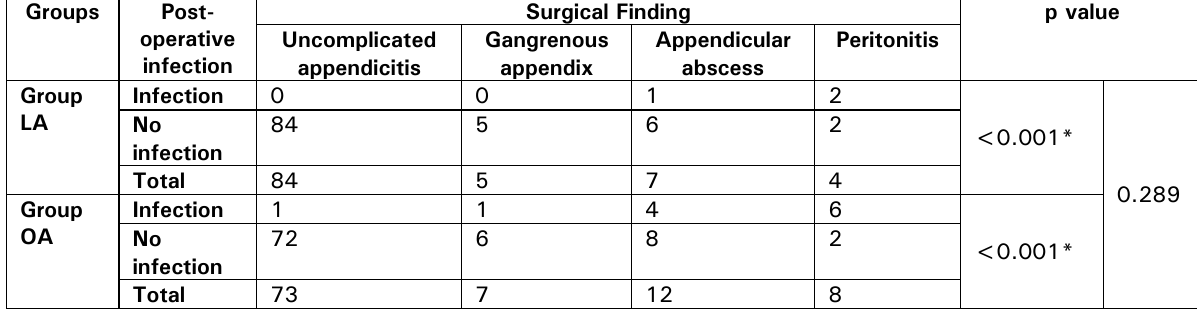
Table 3: Comparison of intraoperative finding between Laparoscopic Appendectomy and Open Appendectomy